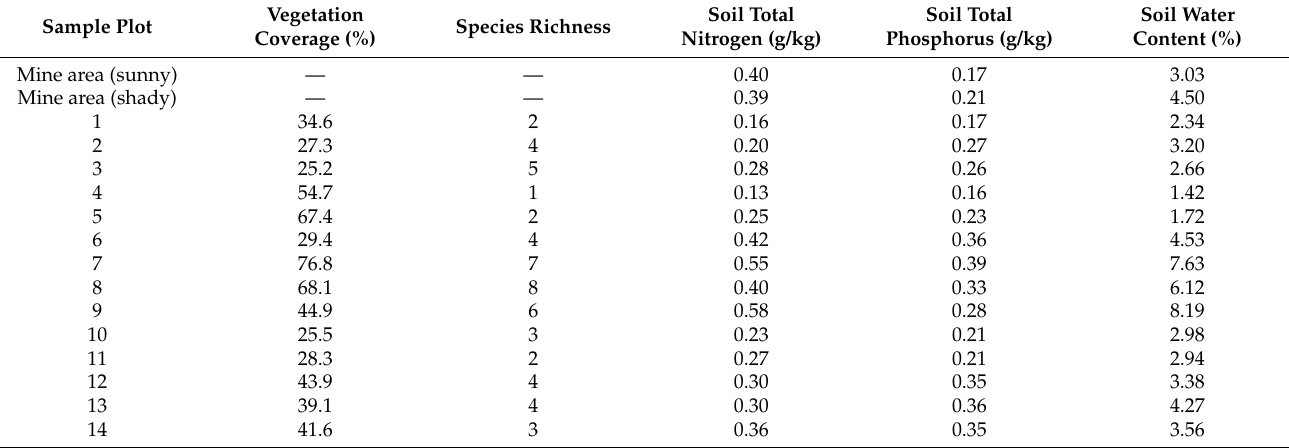
Table 1. Vegetation and soil conditions of the plots. Vegetation Species Richness Coverage (%)